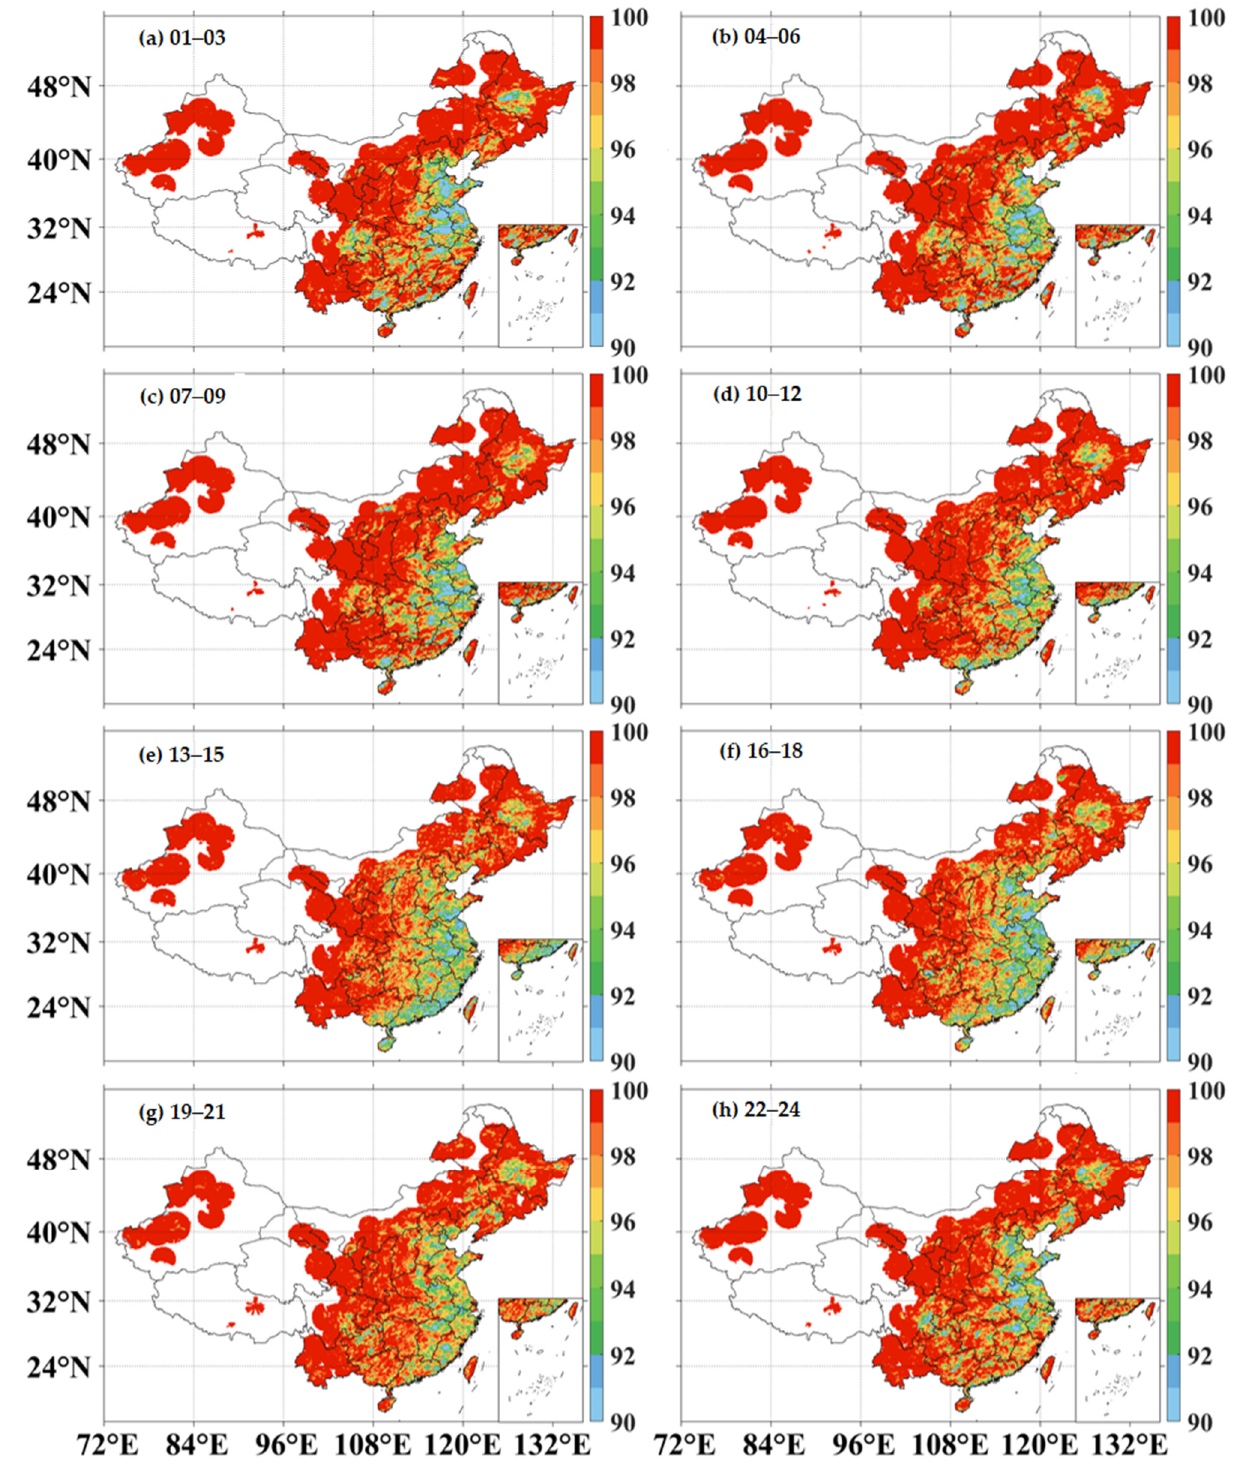
Figure 12. Diurnal variation of frequency (%) distribution of stratiform precipitation for period